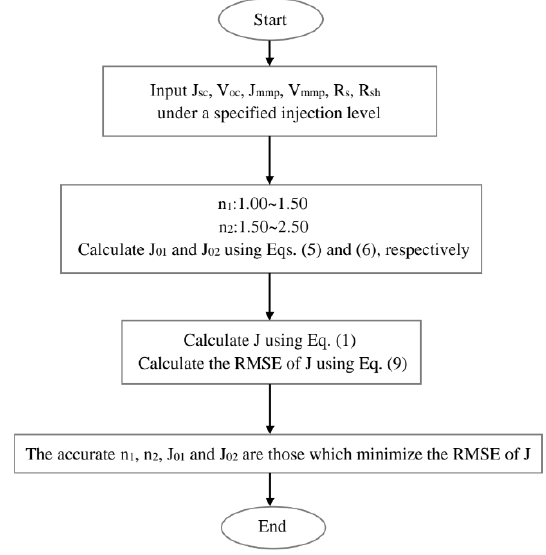
Figure 3. Flowchart to find the J 01 and J 02 under different injection levels. Table 2. The J 01 , J 02 , and root mean square error (RMSE) of current density for an Al-BSF solar cell.